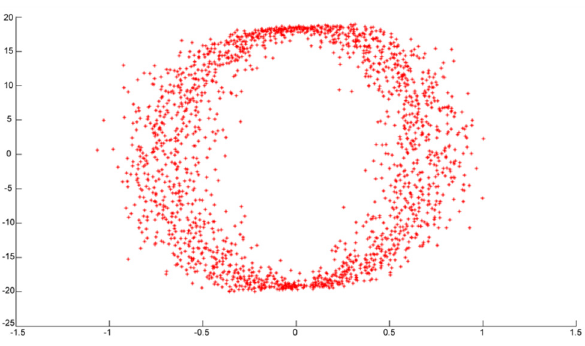
Figure 10. Chaotic trajectory for power system signal with voltage sag disturbance.